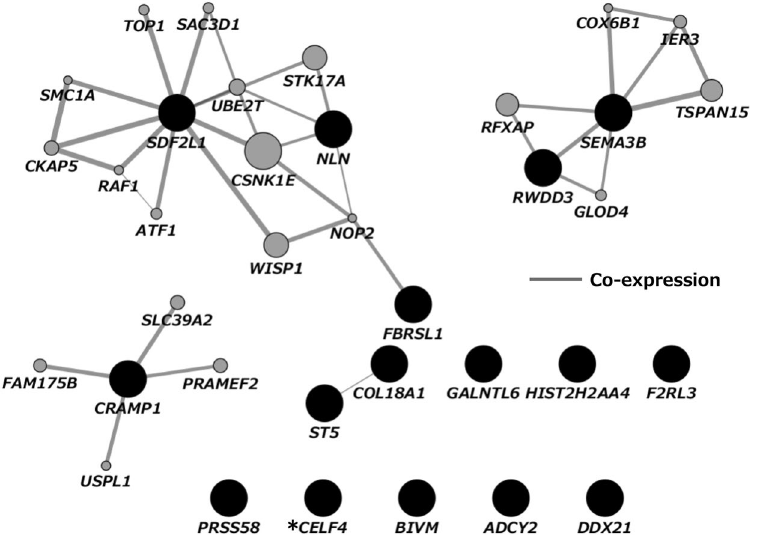
Figure 4. Gene network analysis using GeneMANIA. Dark circles represent genes associated with the 16 DMPs found to be related to BPA exposure in the female-only analysis. Light circles represent additional genes predicted by GeneMANIA based on genetic and physical interactions. * CELF4 , an alias for BRUNOL4 .